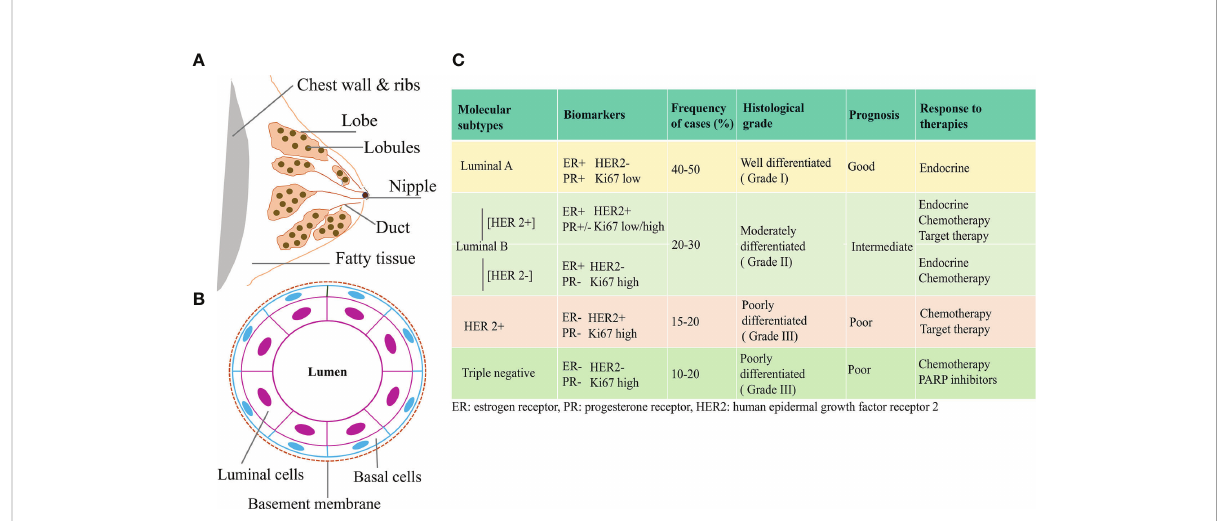
FIGURE 1 Classi fi cation of Breast Cancer (A) Breast showing the different tissue types consisting of duct, lobe, lobules, nipples, and fatty tissue. (B) Cross-sectional view of mammary duct, consisting of basal cells and luminal cells. Breast cancer arising from the luminal or basal cells can be further characterized based on the expression of different hormone receptors. (C) Based on the expression of ER, PR, HER2, and proliferation status as assessed by Ki67, different molecular subtypes of breast cancer have been identi fi ed that have distinct prognostic features and response to therapies